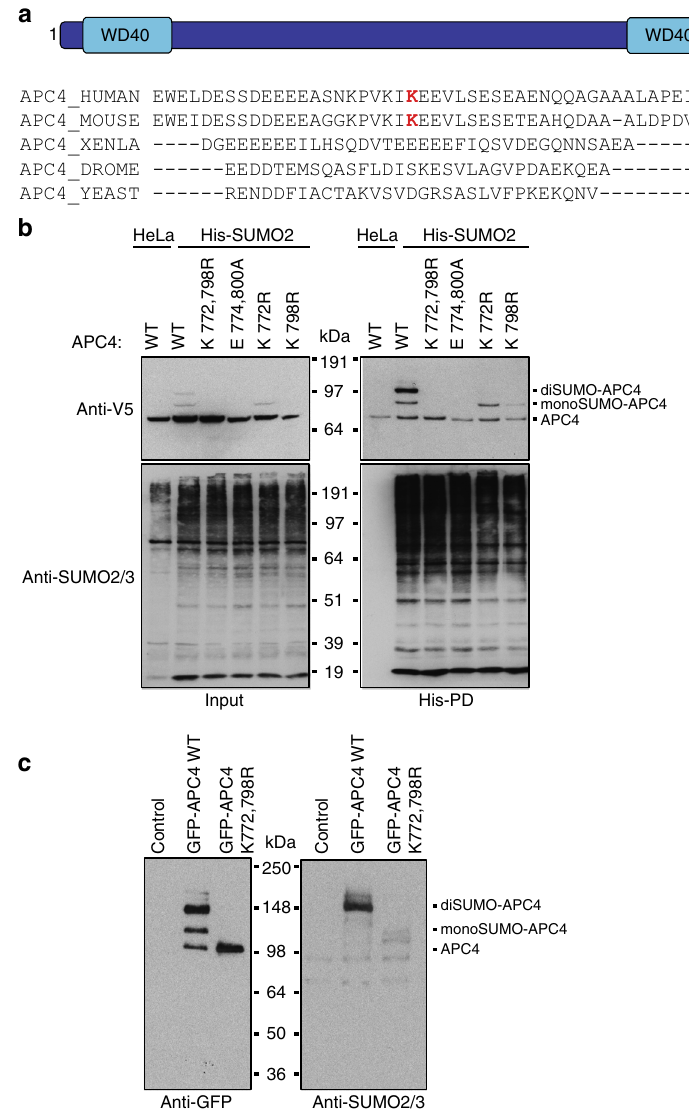
Fig. 3 K772 and K798 of APC4 are the main SUMOylation sites within the APC/C. a Schematic overview of the APC4 subunit of the APC/C: The protein consists of 808 amino acids and contains a WD40-like domain split by a helix bundle domain. The lysine residues K772 and K798 identi fi ed to be SUMOylated (red) are situated at the C-terminal part of the protein. The C-terminal domain of human APC4 was aligned with the C-terminal domains of the homologs from Mus musculus (MOUSE), Xenopus laevis (XENLA), Drosophila melanogaster (DROME), and Saccharomyces cerevisiae (YEAST), demonstrating that the two SUMOylated residues are only conserved in human and mouse. b HeLa cells and HeLa cells expressing His-tagged SUMO2 (His-SUMO2) were transfected with V5-tagged versions of either APC4 wild type or different APC4 mutants. His-SUMO2 conjugates were puri fi ed by His-pulldown (His-PD). Input and pulldown samples were analyzed by immunoblotting with anti-V5 antibody. Equal SUMO2/3 levels were con fi rmed by immunoblotting with anti-SUMO2/3 antibody. Results shown are representative for two independent experiments. c HeLa cells were infected with control virus or retrovirus expressing either APC4 wild type or APC4 K772,798R mutant, both containing an N-terminal GFP-tag. The APC/C was puri fi ed